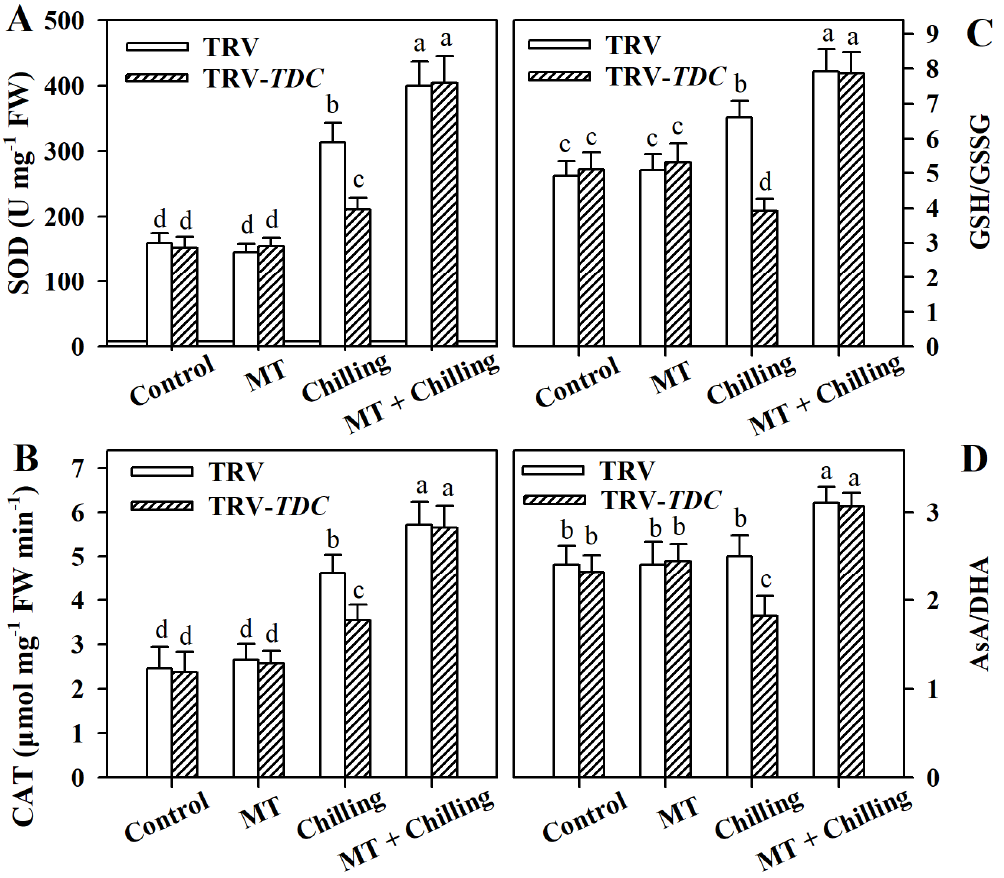
Figure 5. Changes in the antioxidant enzymes and non-enzymatic compounds as affected by TDC silencing and exogenous melatonin in tomato plants under chilling stress. ( A ) Superoxide dismutase (SOD); ( B ) catalase (CAT); ( C ) ratio of GSH/GSSG; ( D ) ratio of AsA and DHA. Tomato plants at the 6-leaf stage were exposed to chilling stress (4 ° C) for 12 h and leaf samples were collected for the determination of antioxidant enzyme activities and non-enzymatic compound levels. The values presented are means ± SDs ( n = 3). Different letters (a–d) above bars indicate significant difference at p < 0.05 among treatments.